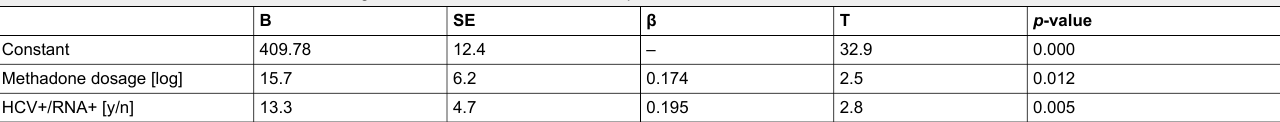
Table 2: Coefficients of the multivariate linear regression model with QTc time as dependent variable. B SE β T p